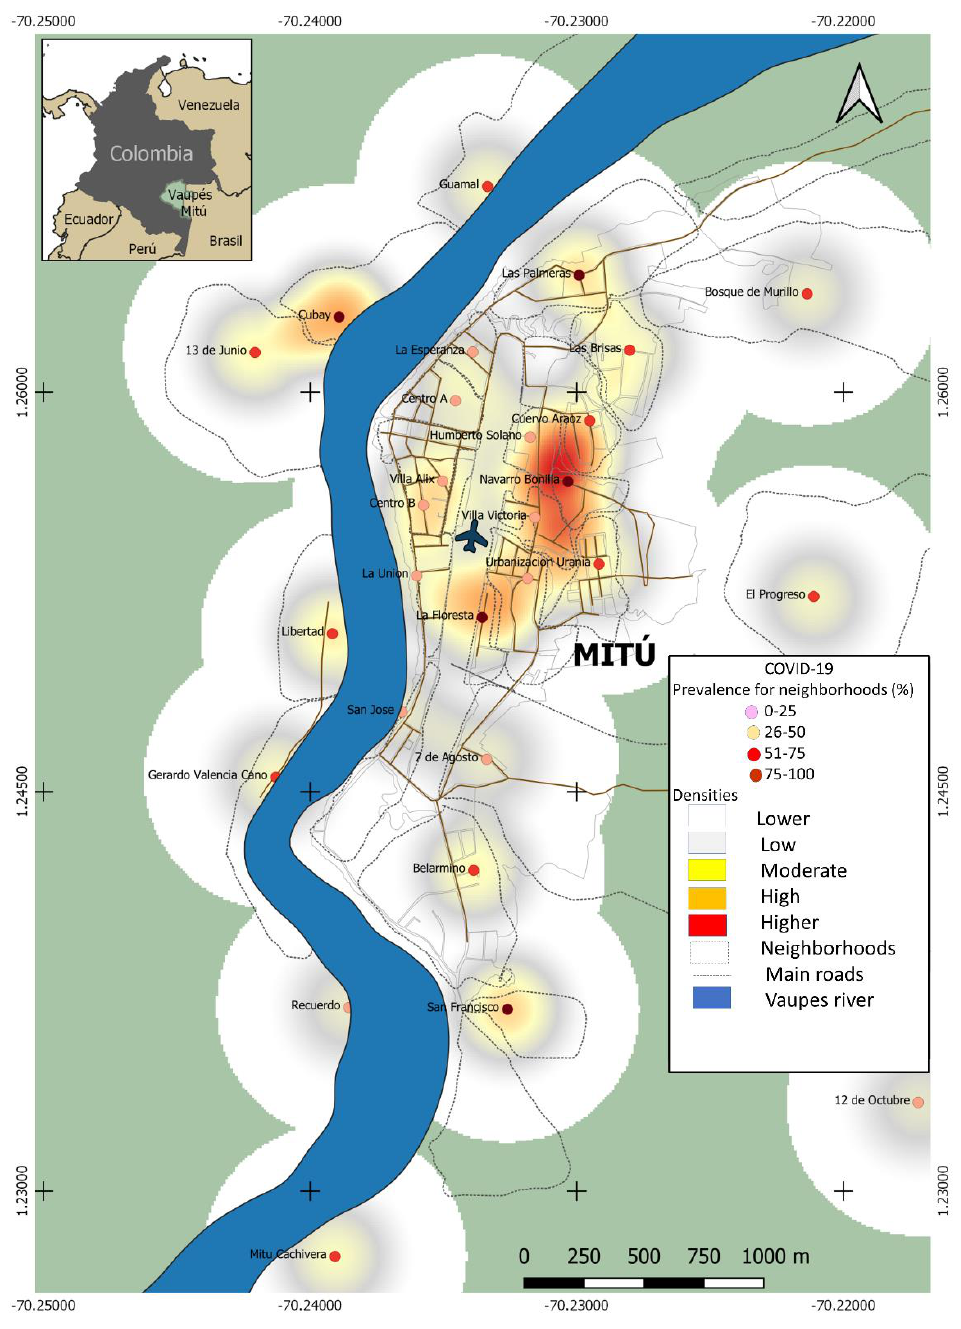
Figure 1. Spatial distribution through point map for SARS-CoV-2 infection in this population. Distribution of SARS-CoV2 cases in Mitú; relevant areas of concentration of infected by SARS-CoV2 close to the airport terminal is